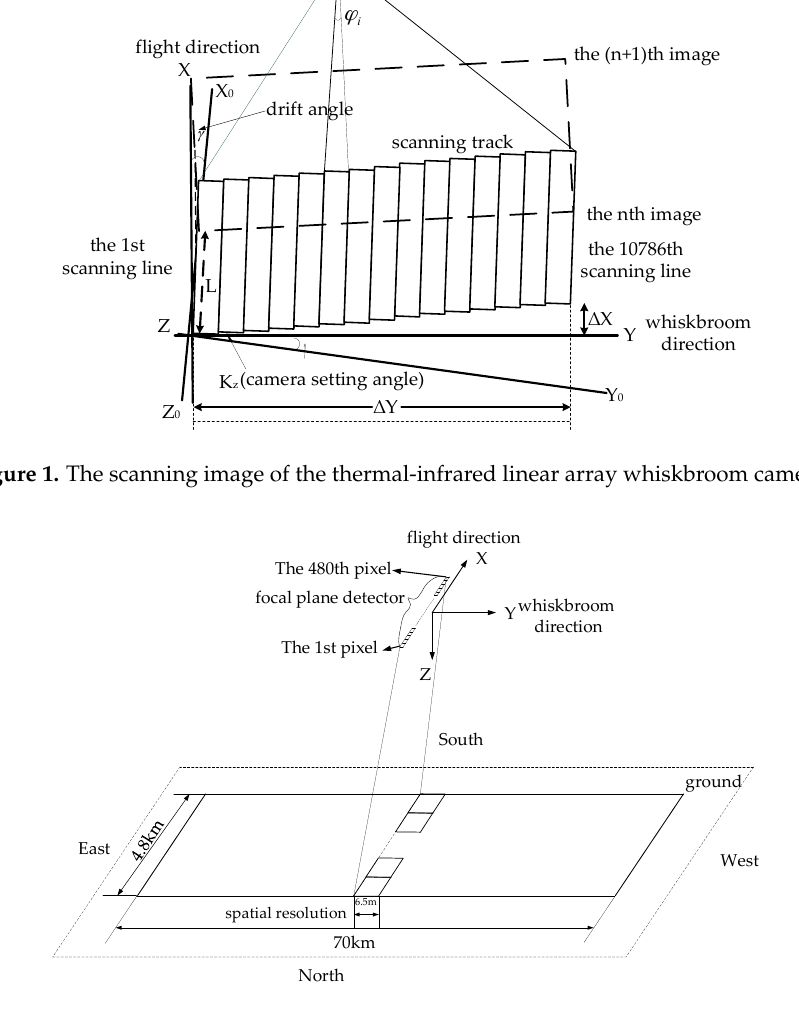
Figure 2. The diagram of the ground projection position of the imaging detector pixel.